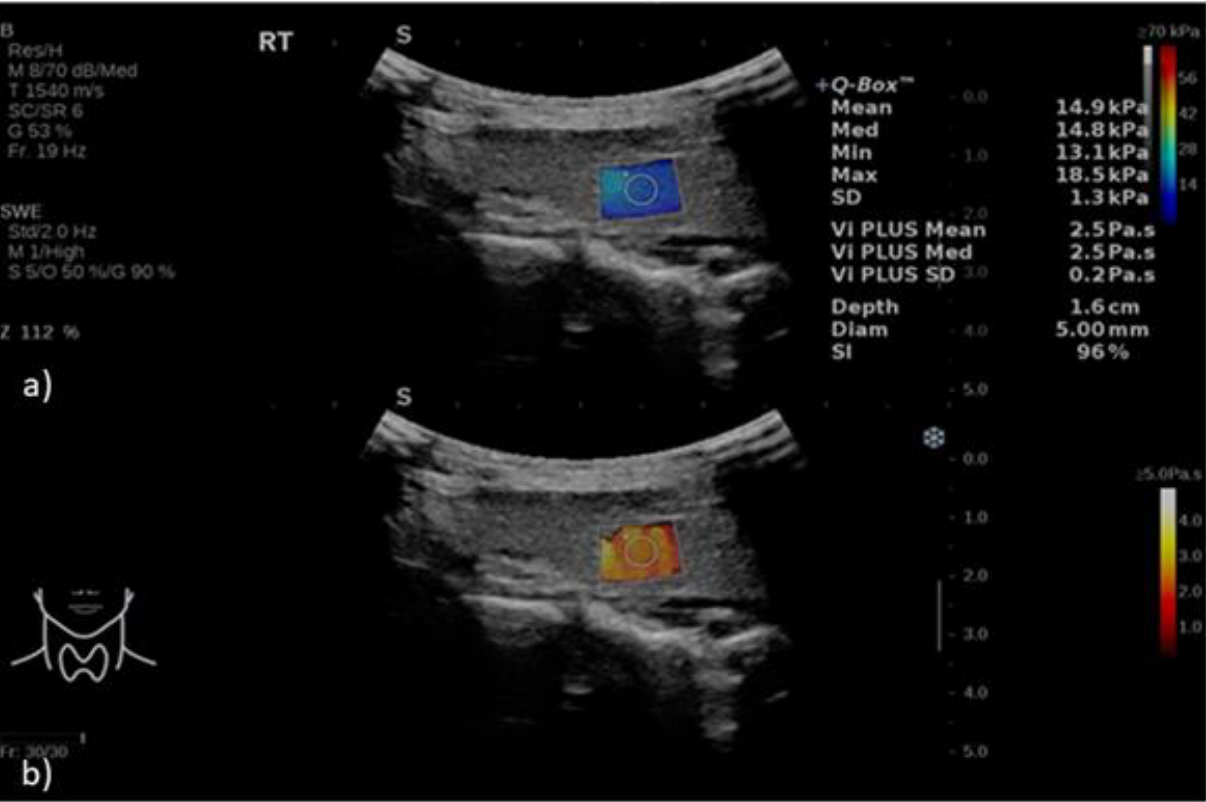
Figure 1. 2D-SWE.PLUS ( a ) and Vi PLUS ( b ) measurements obtained in the right thyroid lobe of a healthy volunteer. Vi PLUS box represents a duplicate of the SWE box and for each parameter, a color scale map is displayed. For the SWE mode (range 0 to 70 kPa), low elasticity is coded in blue and high elasticity is coded in red. On Vi PLUS mode (range 0 to 5 Pa.s), low viscosity is color-coded in red, while high viscosity is depicted in white-yellow colors. Simultaneously, quantitative assessment is displayed on the right side of the image for Vi PLUS (expressed in Pa.s) and for SWE (expressed in kPa).